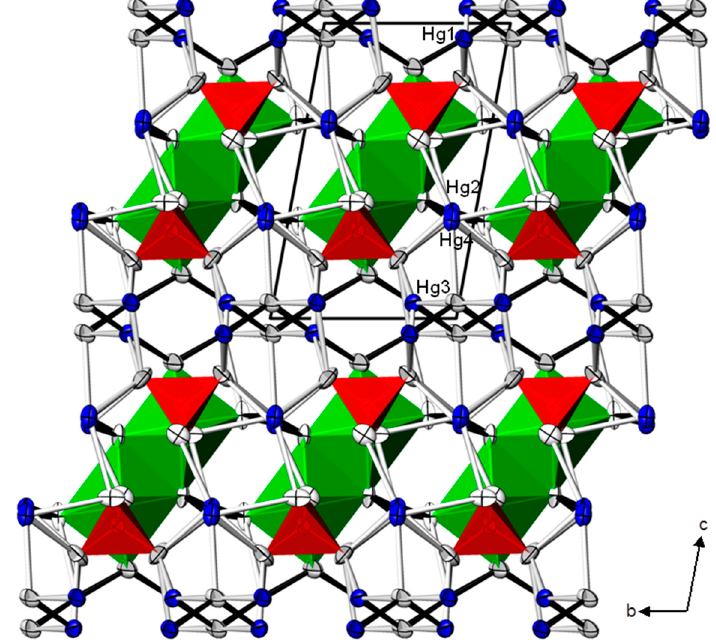
Figure 4. The crystal structure of Zn(Hg II ) 4 O 4 (CrO 4 ). [CrO 4 ] tetrahedra are red, [ZnO 6 ] octahedra are green. Displacement ellipsoids are as in Figure 3.